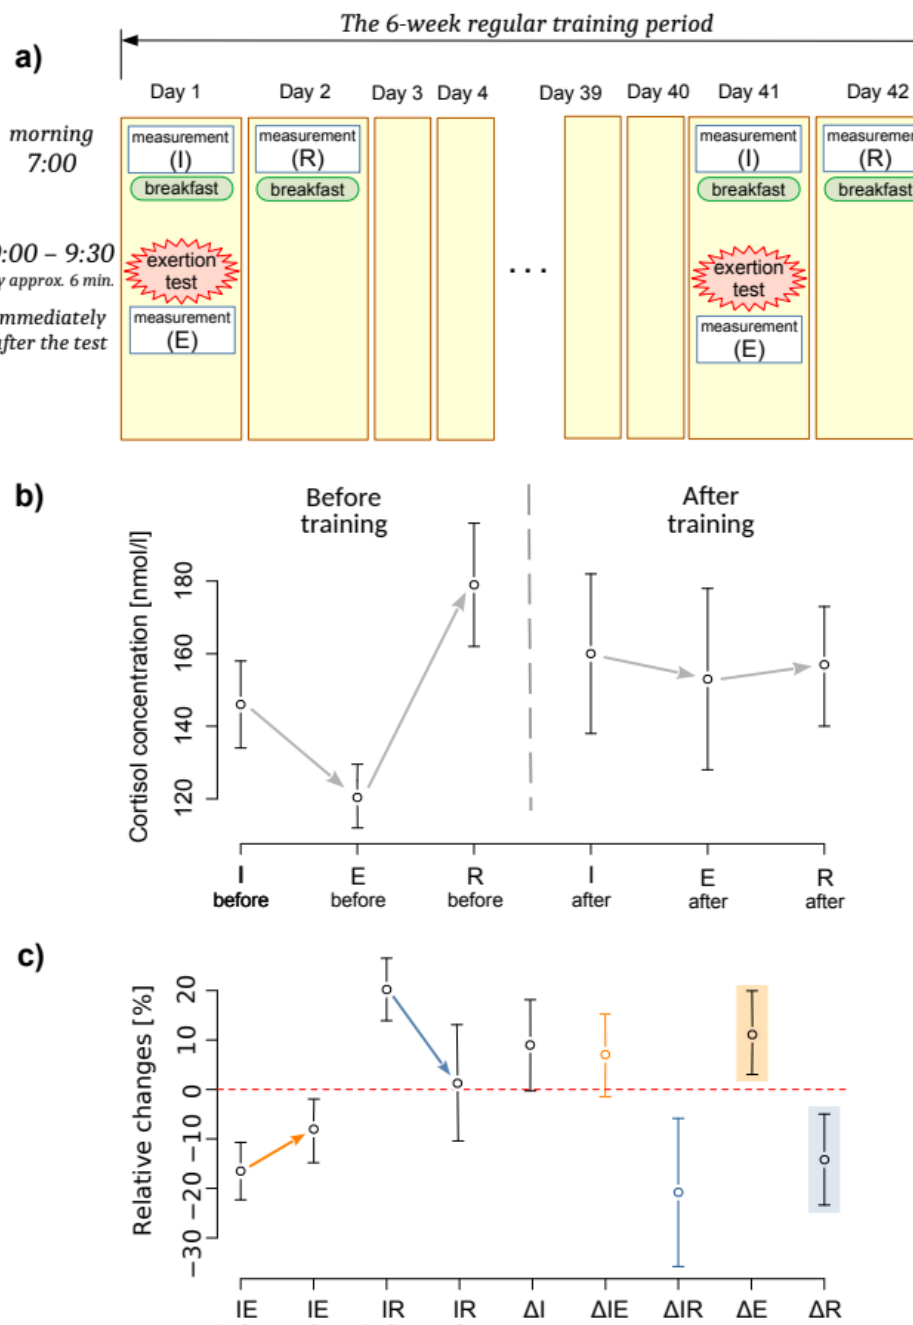
Figure 1. The experimental protocol ( a ), the training-derived changes in cortisol concentrations shown by the mean values of cortisol concentrations (I, E, R) ( b ) and the relative changes representing the reaction to the test (IE, IR) and training effect ( Δ I, Δ IE, Δ IR, Δ E, Δ R) ( c ), along with their 95% confidence intervals. The test-induced reactions approached zero (weakened) as the IE value increased (yellow arrow and point-and-whiskers) and the IR value decreased (blue arrow and point-and-whiskers).